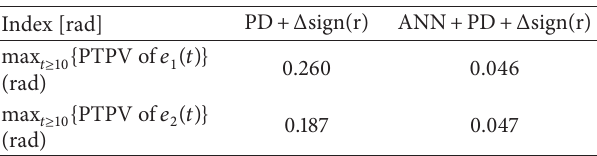
Table 4: Identified parameters of the vertical one degree-of- freedom